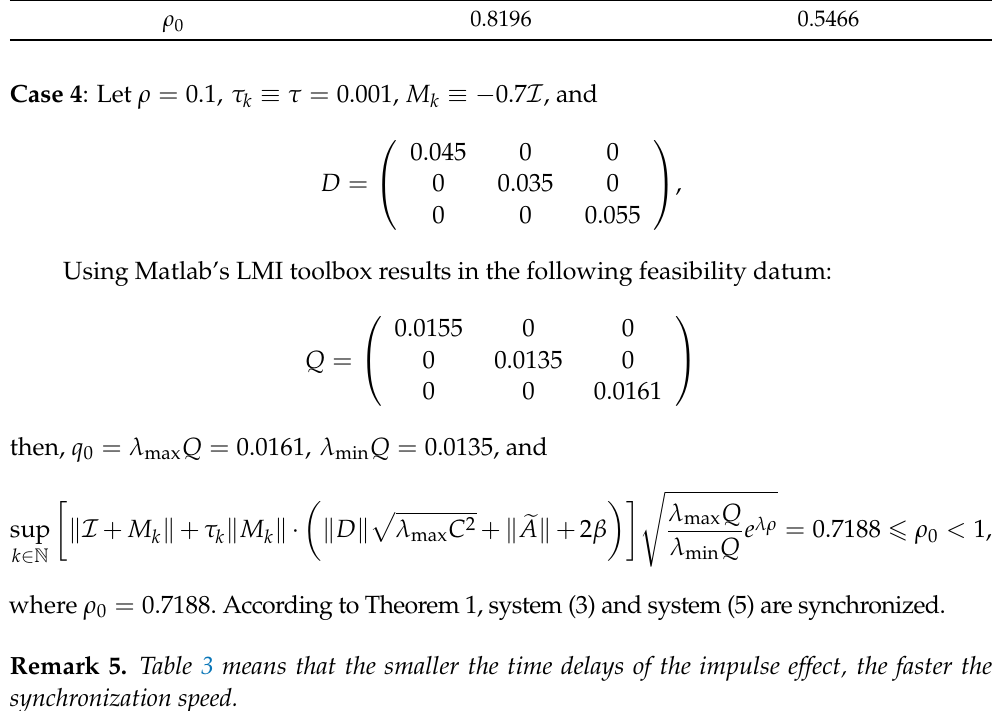
Table 2. Comparison of the influence from different impulse intensities when other data are unchanged. Case 1: M k = − 0 . 7 I Case 2: M k = − 0 . 8 I ρ 0.1 0.1 τ k 0.01 0.01 ρ 0 0.8196 0.5466